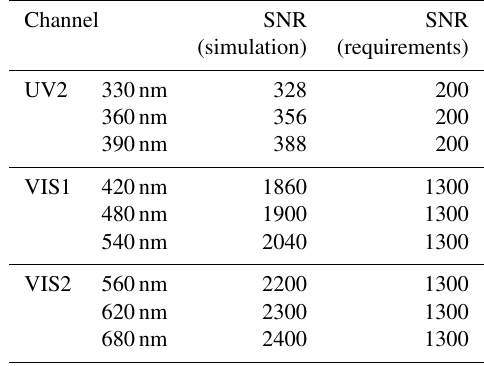
Table 9. In-orbit simulation SNR at the requirement